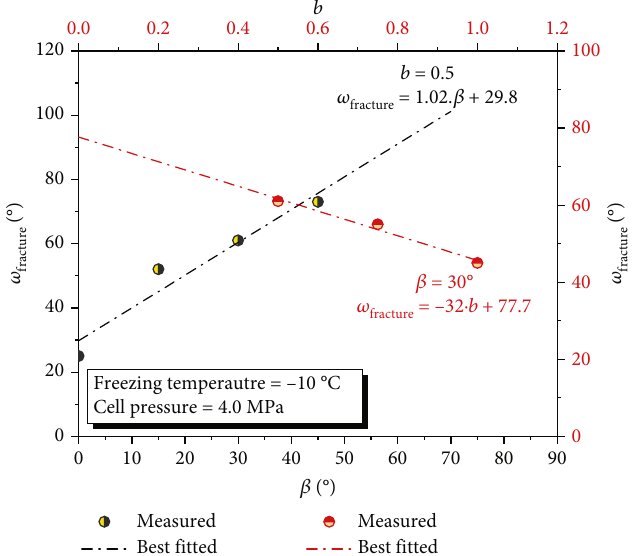
β and b in frozen saturated sand. Figure 17: ω fracture vs.